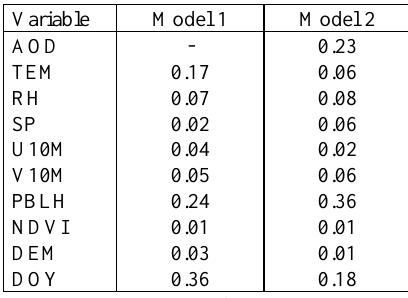
Table 4. VIM of two